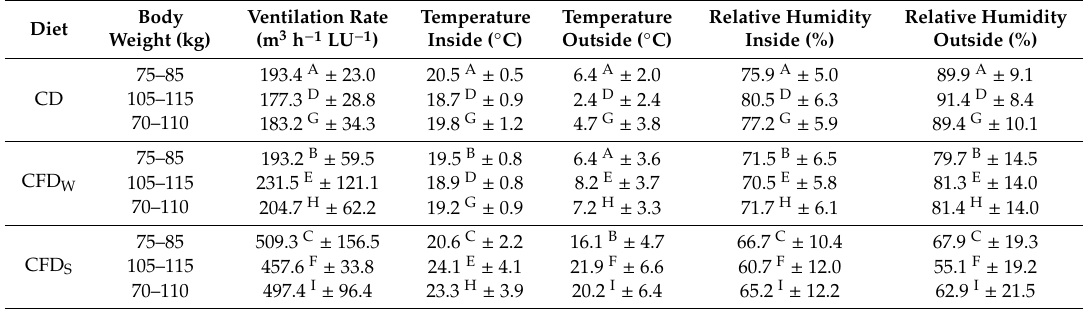
Table 7. Climatic conditions during control and experimental feeding. Mean ± standard deviation.